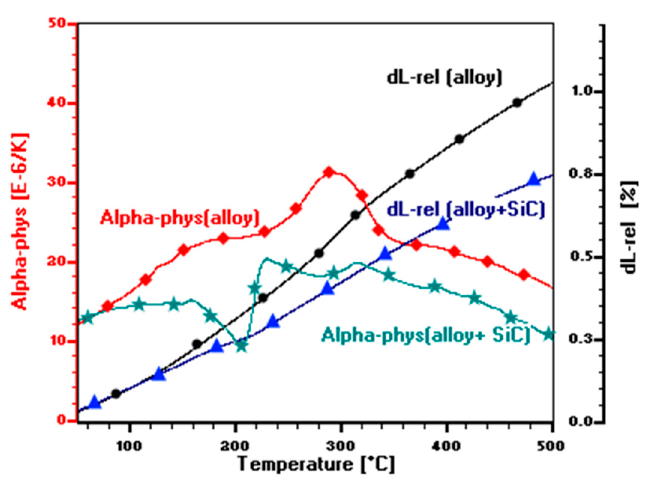
Figure 7. Comparative dilatometric analysis of the alloy and the composite.